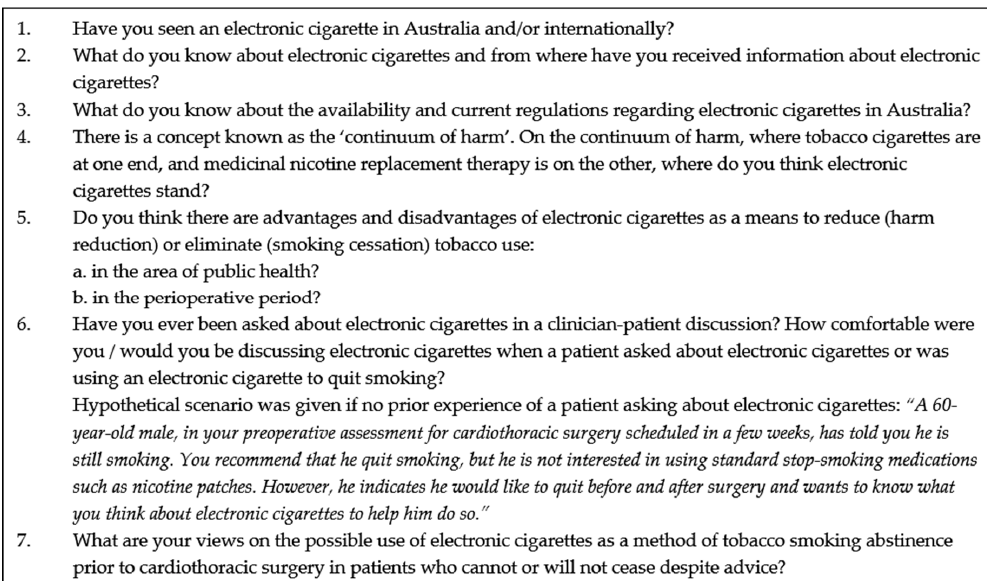
Figure 1. Interview Guide Questions.